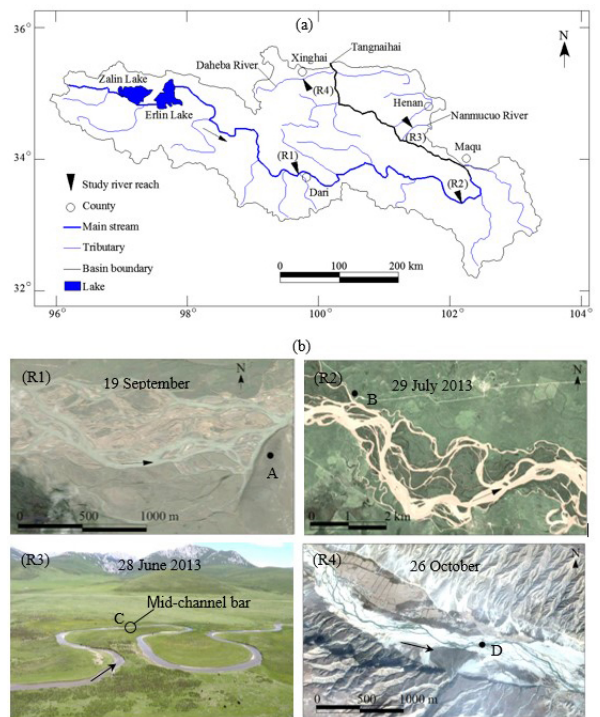
Figure 1. (a) The course of the Upper Yellow River. R1 is the Dari reach, R2 is the Maqu reach, R3 is the Lanmucuo River, and R4 is the Daheba River, (b) Planform morphology of the study reaches (R1 is the Dari reach, R2 is the Maqu reach, R3 is the Lanmucuo River reach, and R4 is the Daheba River reach). R1, R2, and R4 are Google Earth images and R3 is a photograph taken from nearby hills. Points A–D are the location of photographs shown in Fig. 2.